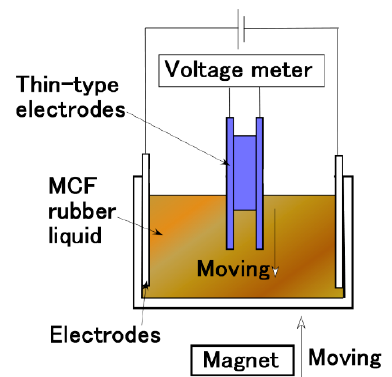
Figure 12. Schematic diagram of experimental apparatus to investigate the output voltage through MCF rubber liquid to input of an external dc voltage.